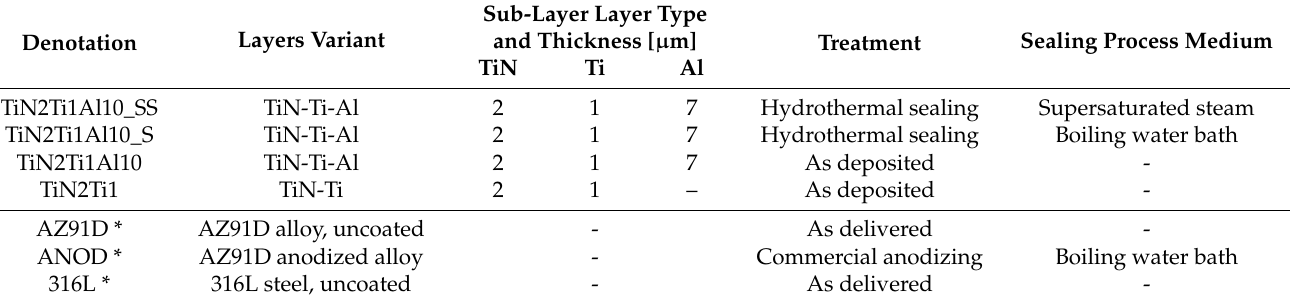
Table 1. Investigated variants of layers on AZ91D alloy and reference materials with denotation.